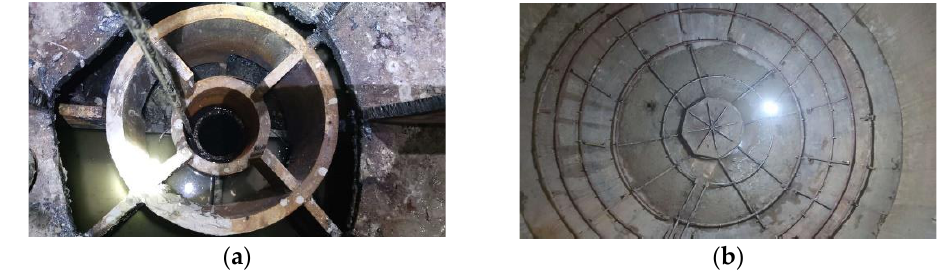
Figure 6. Homogeneous pulp-making equipment; ( a ) Section of the lower sand mouth and ( b ) Slurry ring pipe.